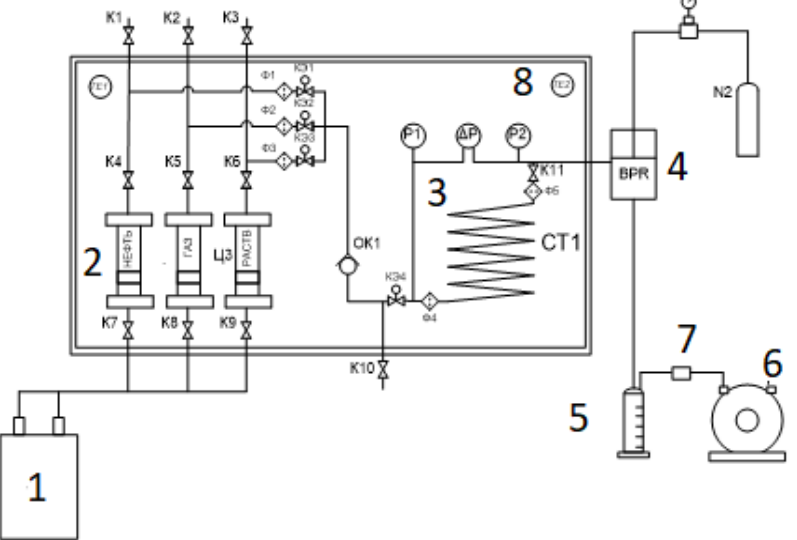
Figure 1. Slim tube unit: 1—High-pressure pump providing a constant flow; 2—piston-type containers; 3—slim tube; 4—back pressure regulator that maintains a constant pressure at the outlet of the slim tube; 5—an oil and gas separator and cylinder with balances to measure the produced oil volume; 6—a gas meter with automatic follow up to measure the produced gas volume; 7—sampling points for gas to conduct on stream sampling while production for gas chromatography measurements; 8—air bath to provide constant operating temperature during displacement tests. Table 3. Composition of APG injection gas mixture.